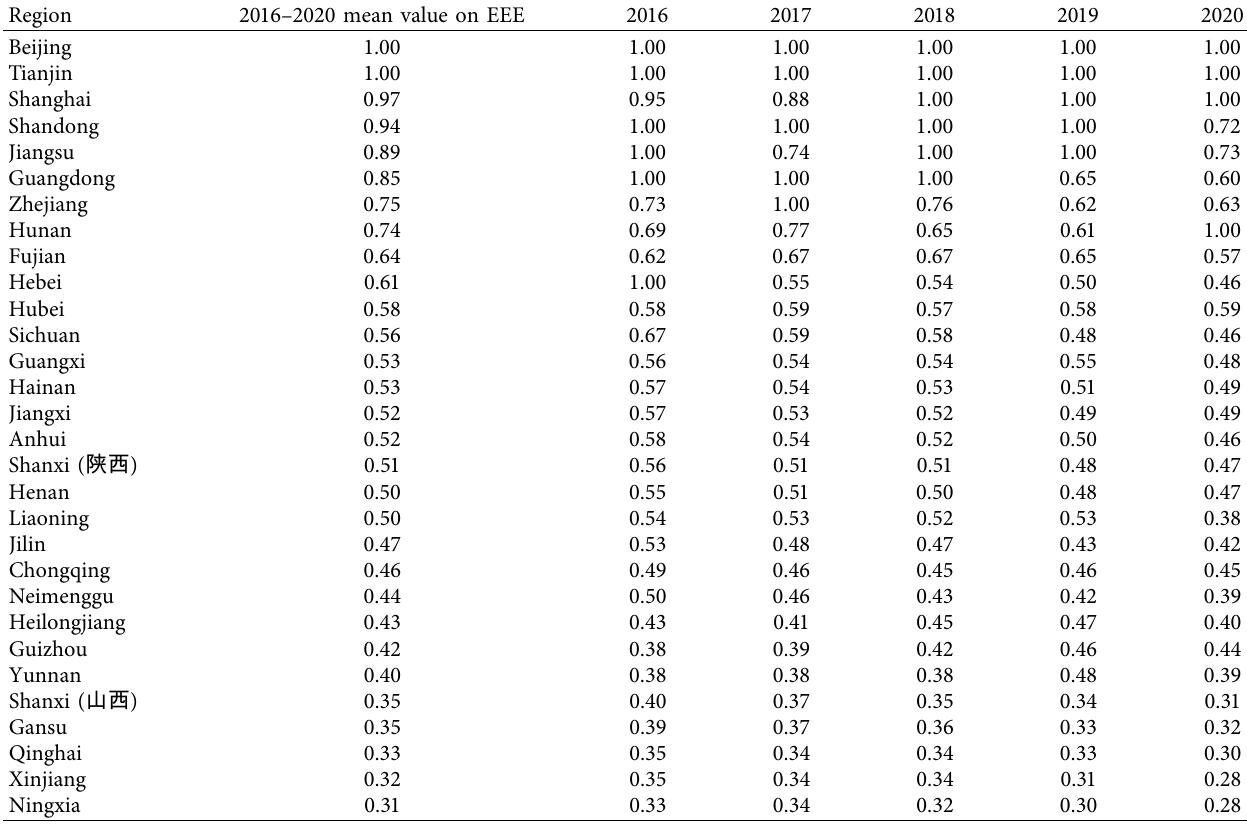
Table 1: EEE evaluation in China.